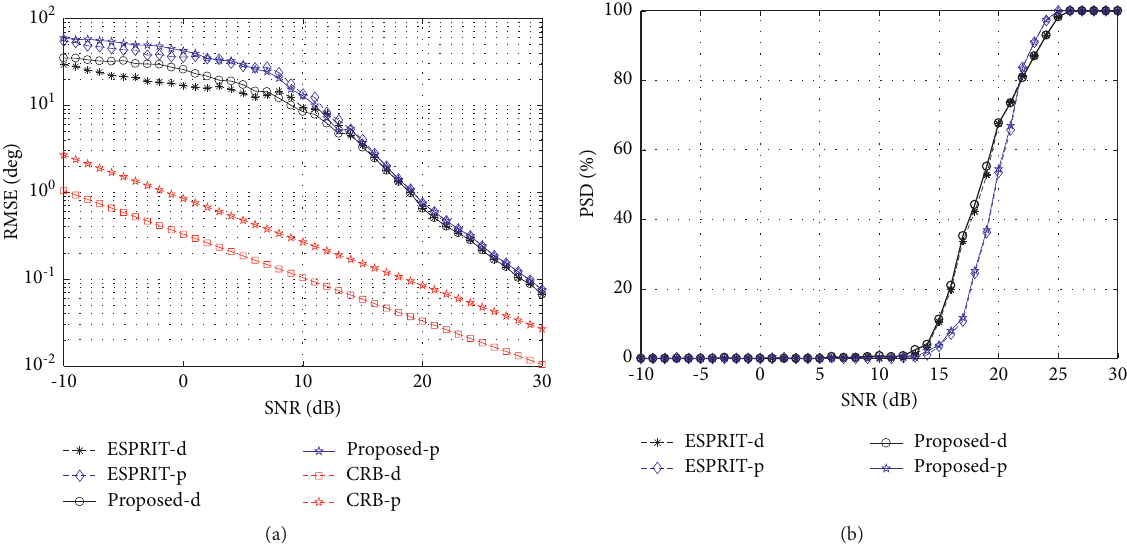
Figure 3: RMSE performance and PSD performance versus SNR (a) RMSE vs. SNR (b) PSD vs.